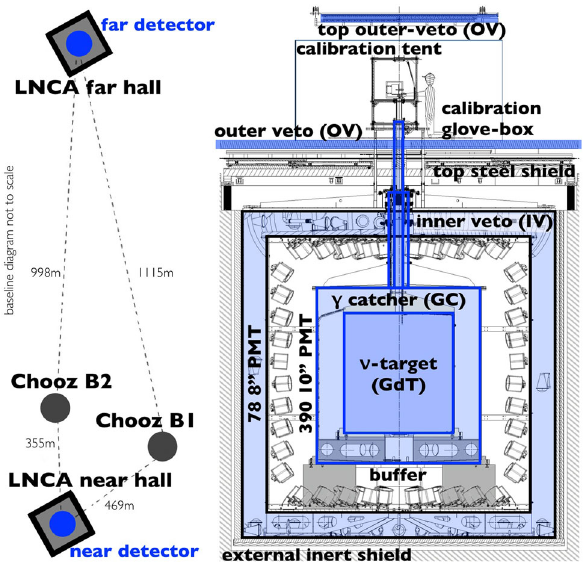
Fig. 1 ArrangementofthetwoDCdetectorswithrespecttothenuclear reactors (left) and sketch of the detector design (right) [7]